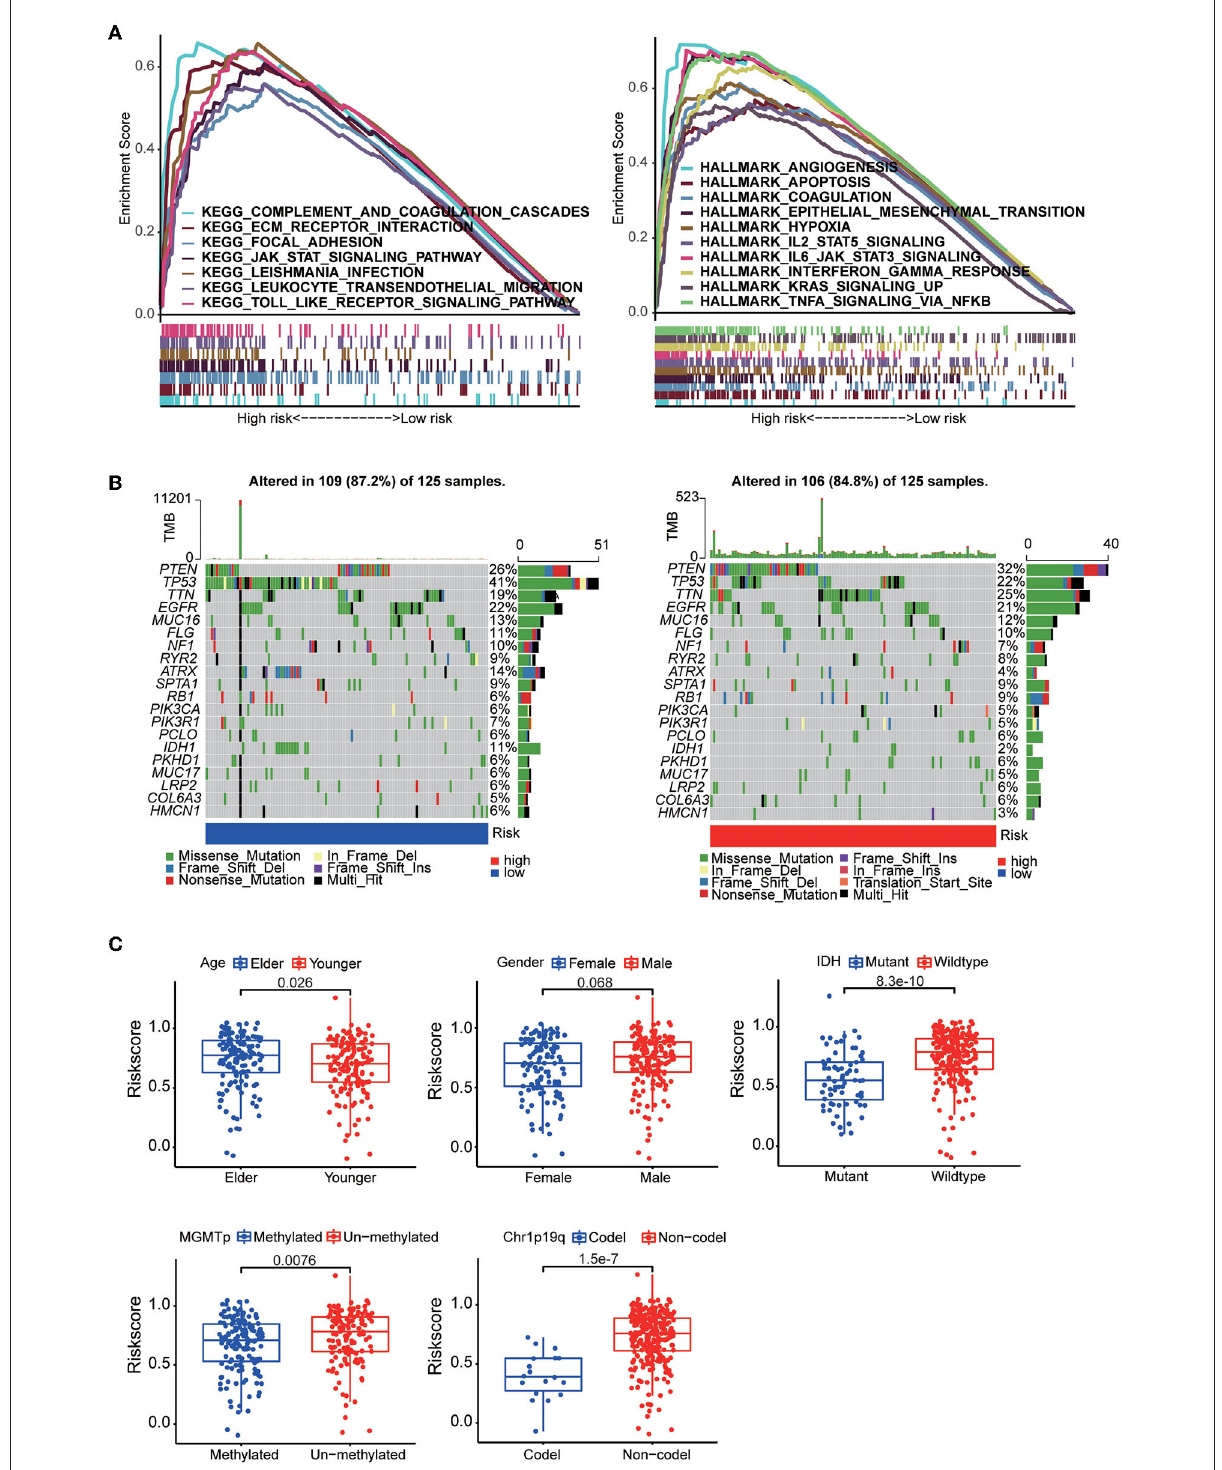
FIGURE5 (A) GSEA between the high-risk group and the low-risk group based on the HALLMARK gene sets and KEGG gene sets. (B) The somatic landscape of the low-risk group samples and high-risk group samples. Mutation information for each gene in each sample is shown in waterfall plots, with different colors at the bottom representing specific annotations indicating various mutation types. (C) Boxplots showing the distribution of risk scores in GBM samples categorized by different factors, including age, sex, IDH mutation status, MGMT promoter methylation status, and chr1p19q codeletion